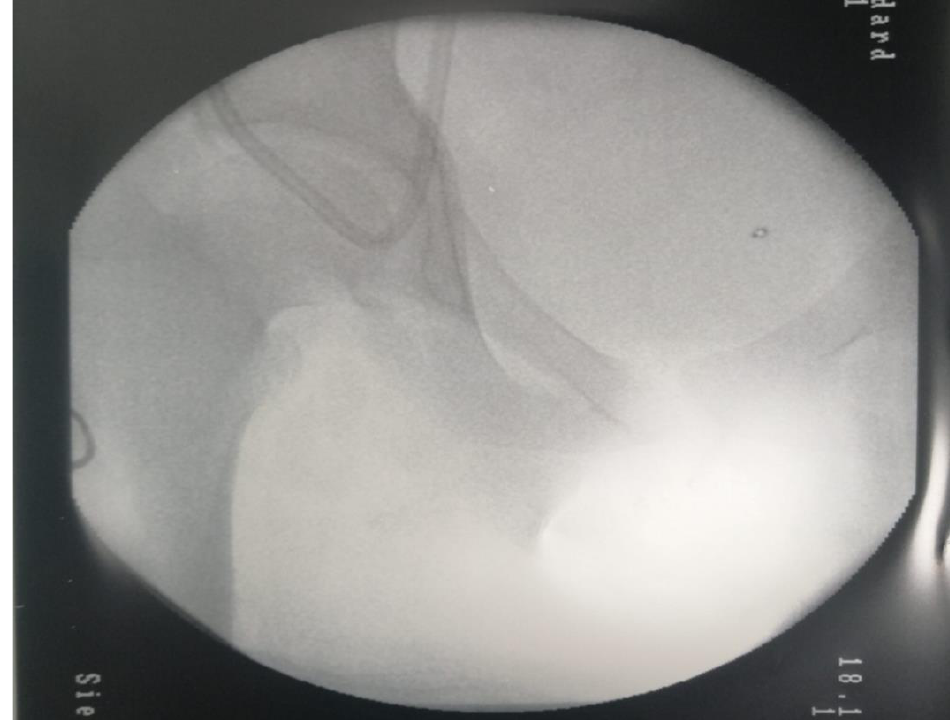
Figure 7. CT scan, left IJV thrombosis. (white arrow).